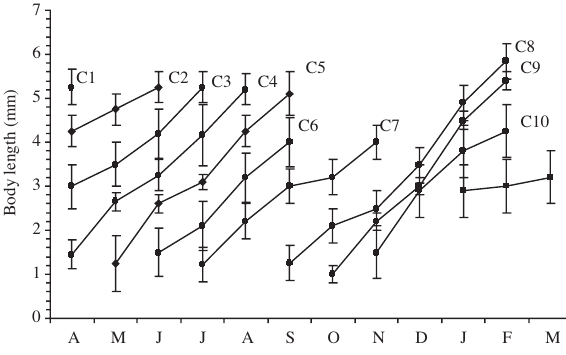
F IG . 8. – Development over time of the C. insidiosum populations; dots: mean body length; bar lines: standard